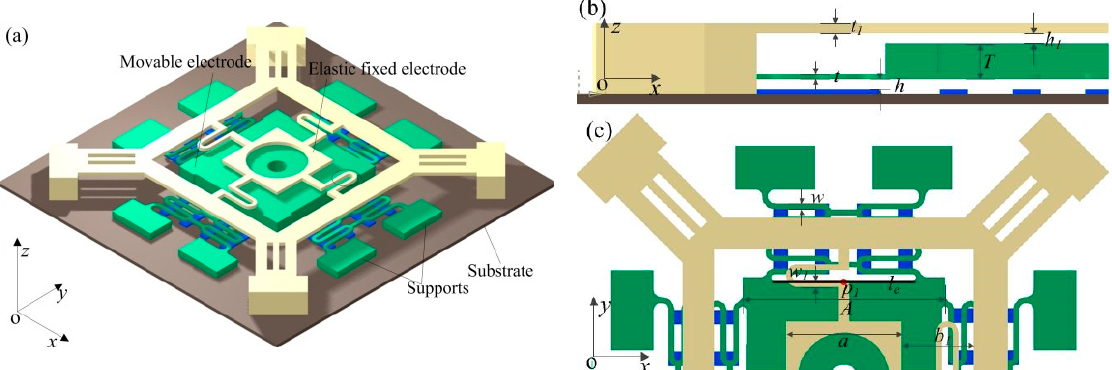
Figure 2. The structure diagrams of inertial micro-switch. ( a ) The 3D view of structure. ( b ) The side view of one-half structure. ( c ) The top view of one-half structure.